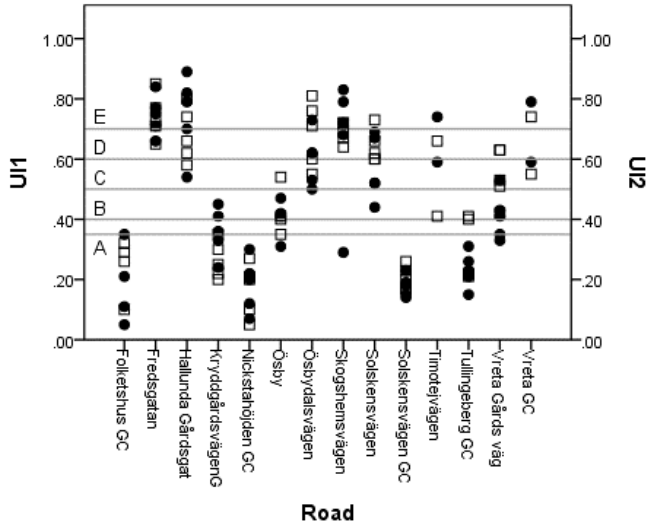
Figure 6. Longitudinal luminance uniformity ( U I ) measured for the 14 roads studied, relative to lighting class boundaries A–E (horizontal lines) in accordance with EN 13201 ‐ 2 [16]: B = M6 ‐ M5/CE5/S4 ‐ S3; D = M4 ‐ M3/CE4 ‐ CE3/S2 ‐ S1; E = M2 ‐ M1/CE2 ‐ CE1 and in accordance with Swedish standards [17]: A = M6/S4; B = M5/CE5/S3; C = M4/CE4;/S2. D = M3-M1/CE3-CE1/S1, where M1–M6 are